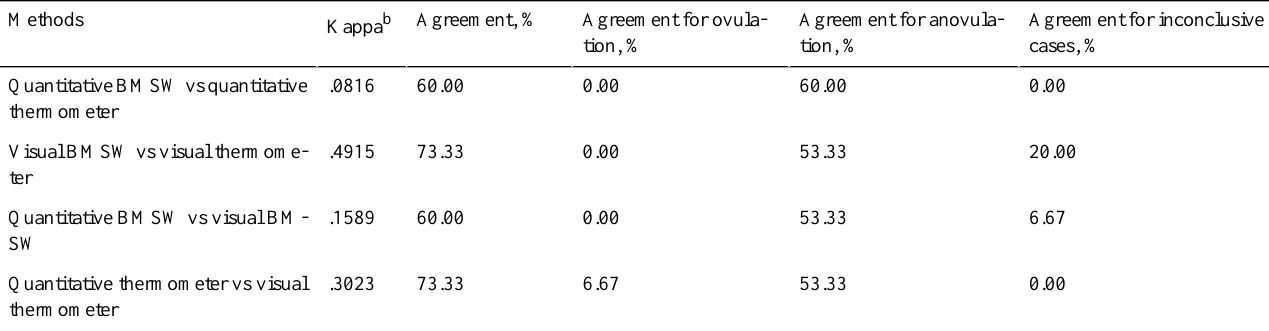
Table 3. Kappa analysis of agreements between BMSW and the thermometer under quantitative a and visual analysis.